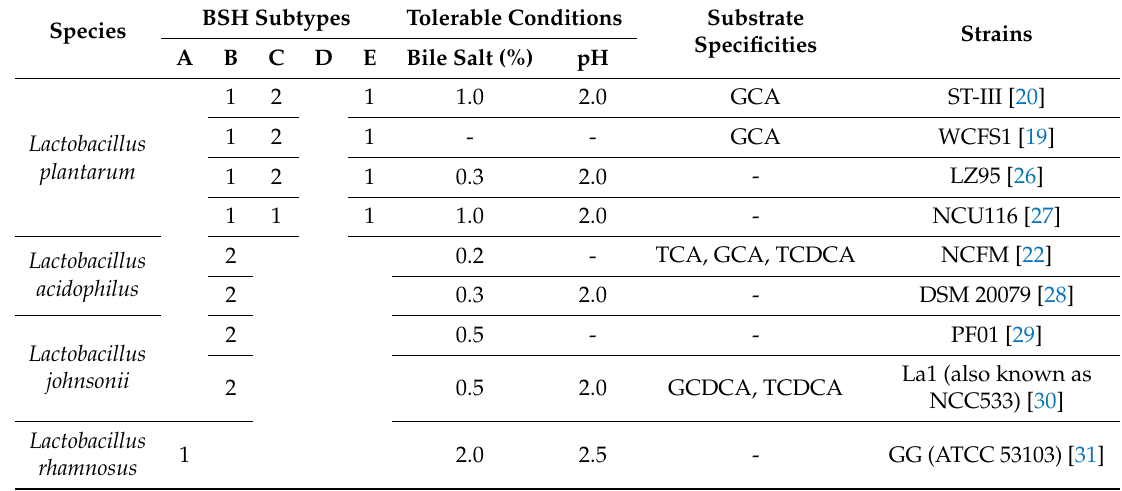
Table 1. Biological activity of representative predicted BSH-active species with diverse BSH subtypes. BSH Species